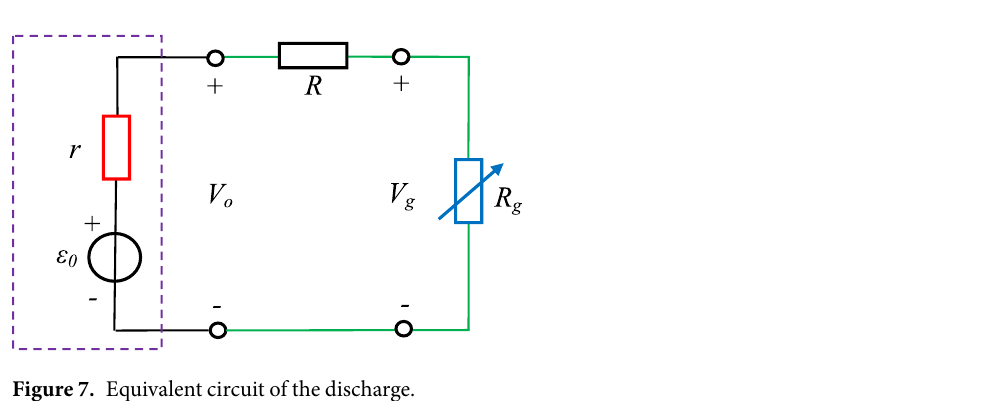
Figure 7. Equivalent circuit of the